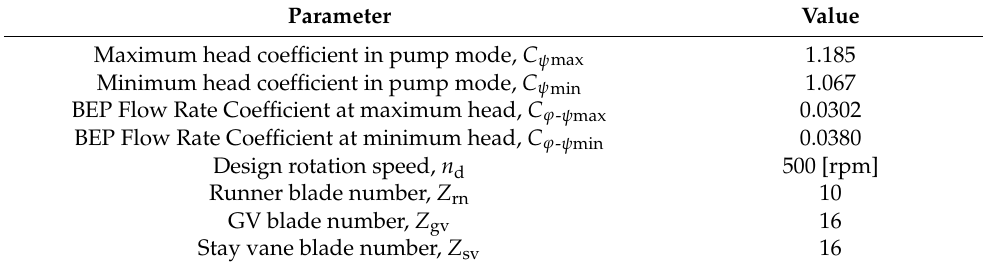
Table 1. Main parameters of the pump-turbine.